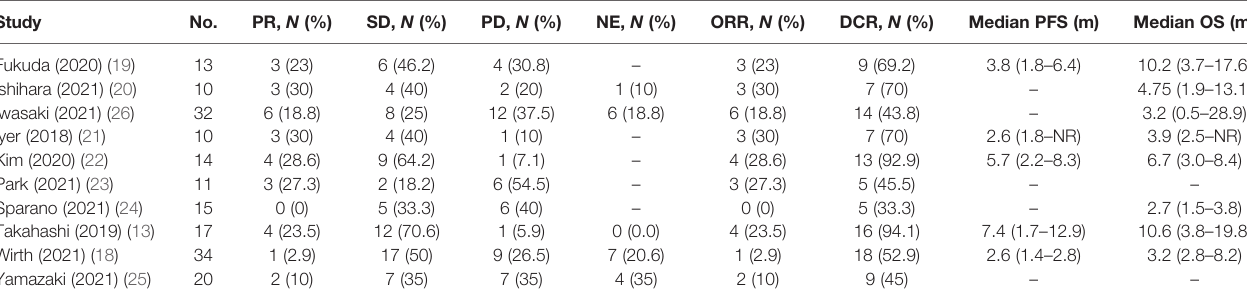
TABLE 3 | Ef fi cacy measurement in each